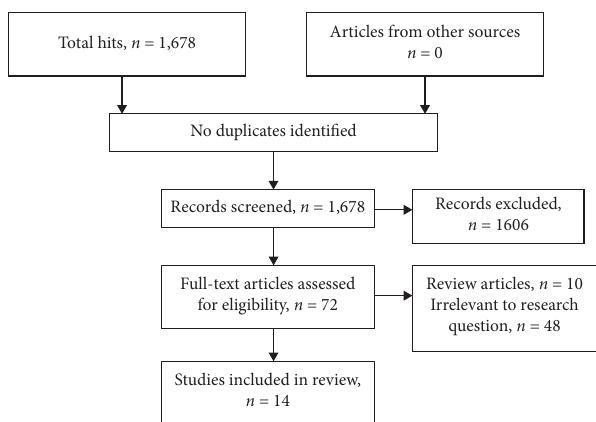
Figure 1: Flow chart of study selection process (PRISMA